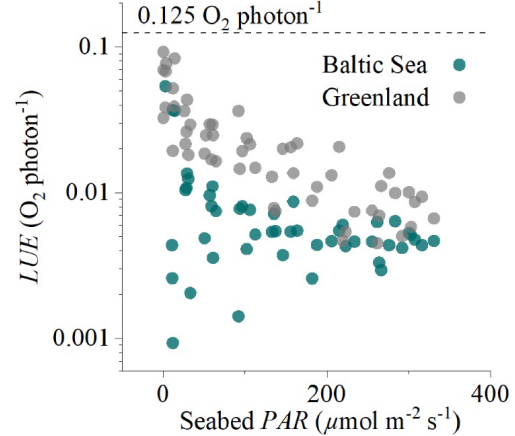
Figure 6. Hourly light-use efficiency (LUE, log axis) plotted against incoming irradiance (seabed PAR) for the two eddy flux datasets collected in the sedimentary embayment in Greenland and the rocky mussel reef in the Baltic Sea. The broken line indicates the theoret- ical limit of 0.125O 2 per